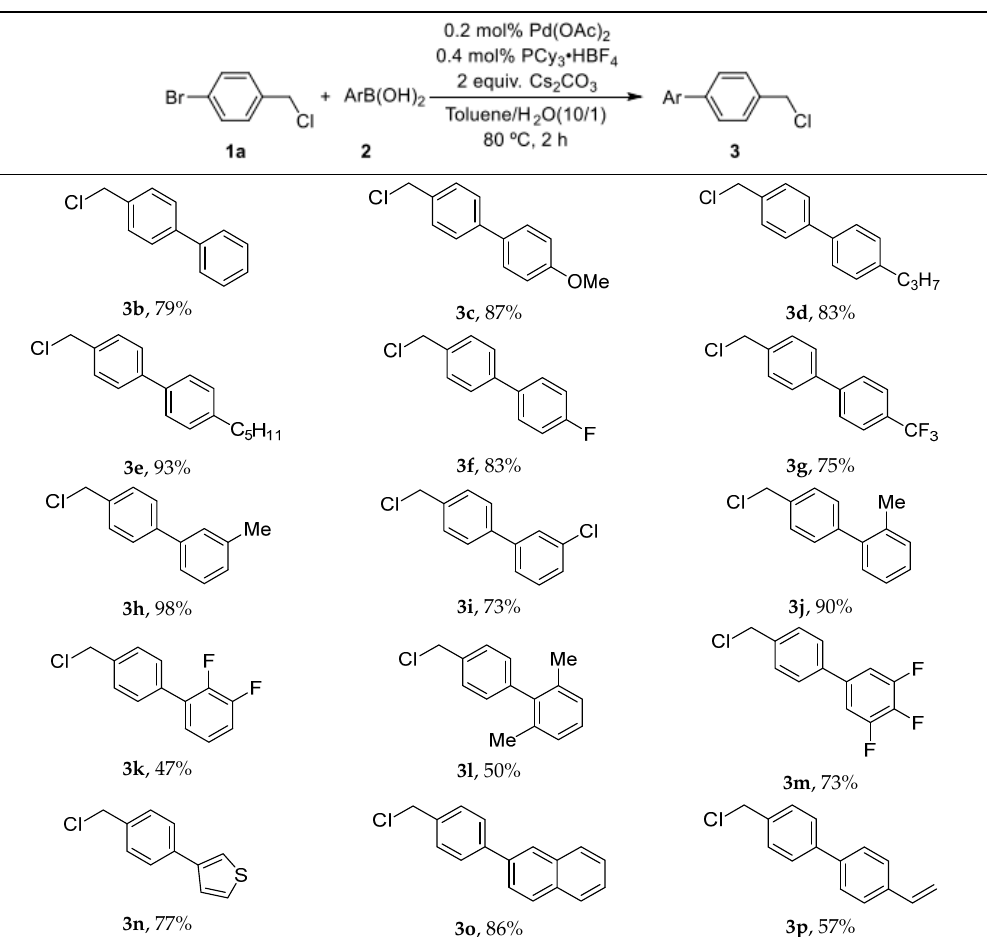
3n , 77% 3o , 86% 3p , 57%